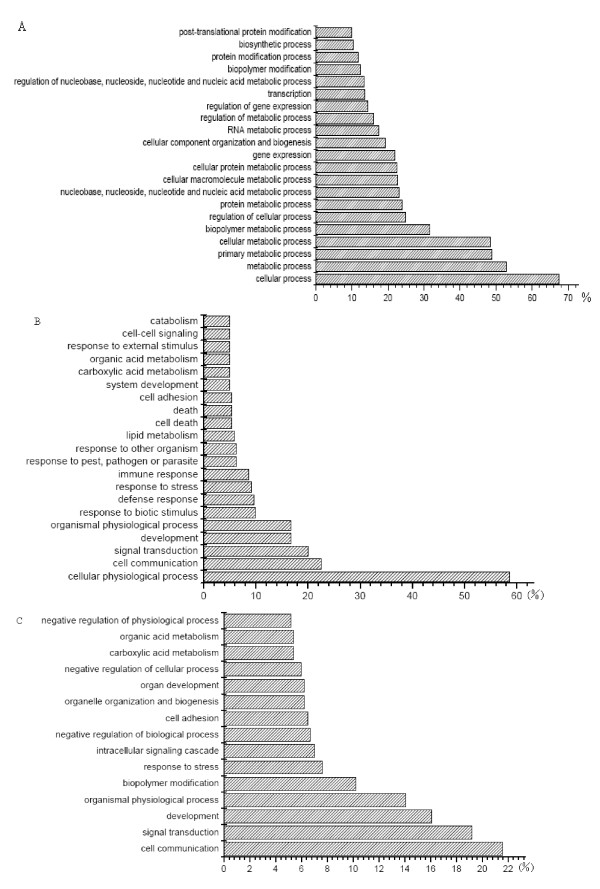
Gene Ontology (GO) molecular function classification of all genes expressed in placenta and differentially expressed genes. (A) All expressed genes in placenta. (B) Differentially expressed genes in E75 vs L75. (C) Differentially expressed genes in E90 vs L90. The x-axis shows the gene percentage of each GO category with regard to the placenta transcripts or the declared differentially expressed genes and the y-axis represents each GO category.